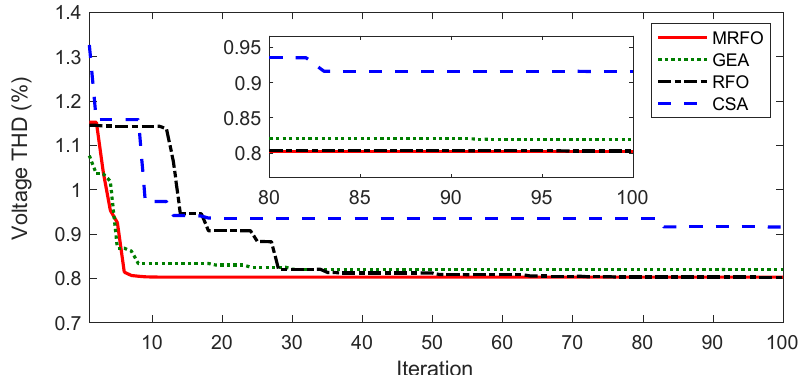
Figure 9. Convergence curves of the algorithms adopted.